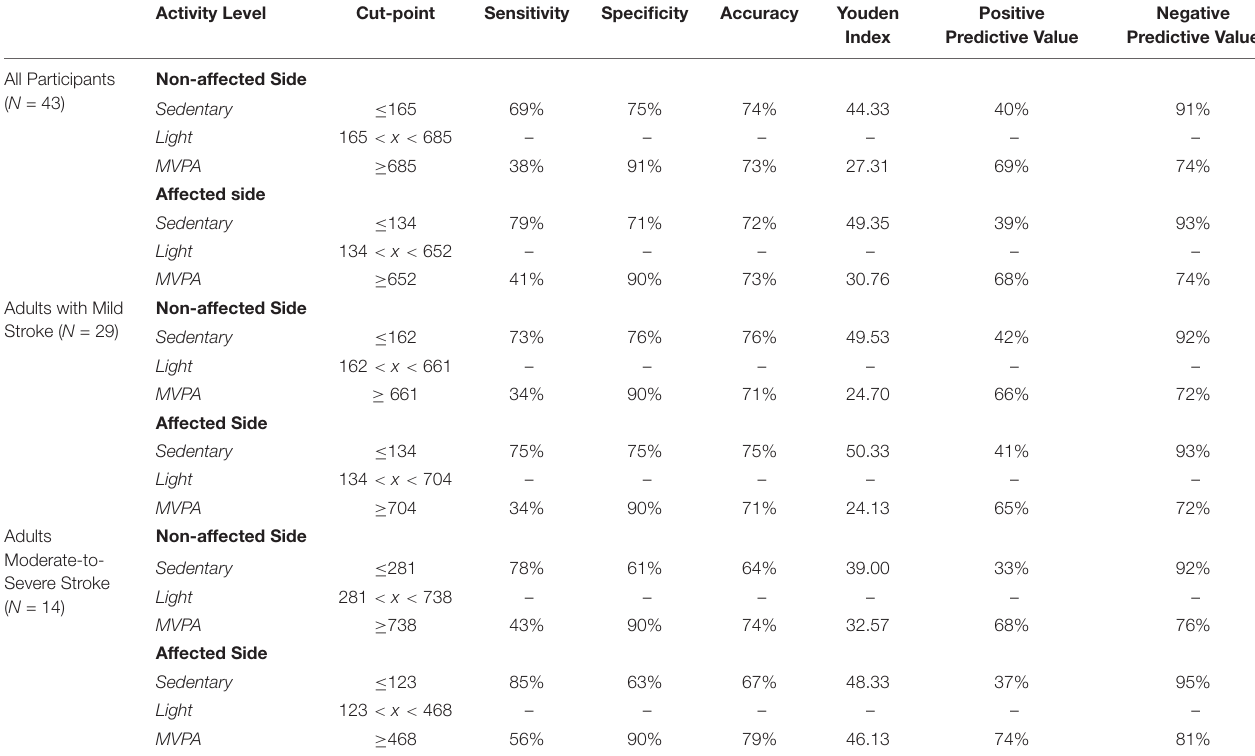
TABLE 3 | Cut-points for MotionWatch8 dependent on